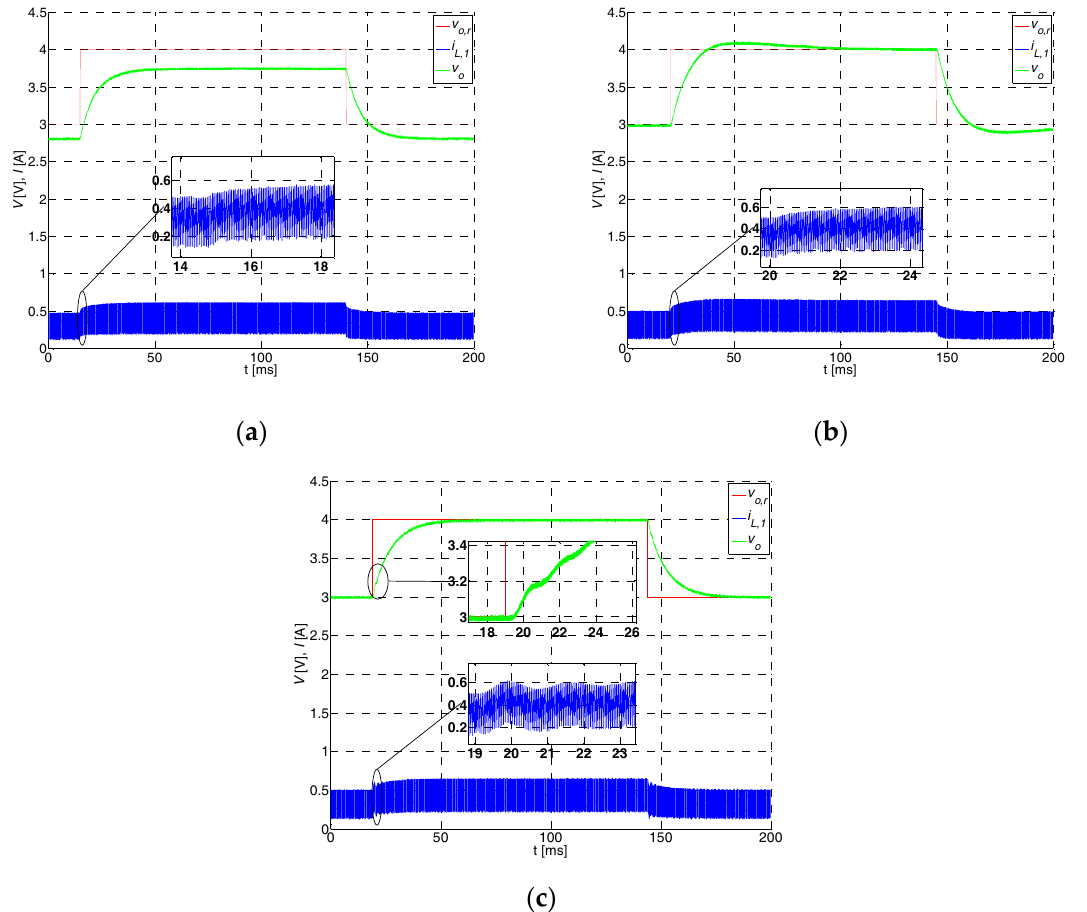
Figure 11. Output voltage response to step voltage reference change when using ( a ) P type control with 𝑖 (cid:3042) feedforward, ( b ) PI control with 𝑖 (cid:3042) feedforward, and ( c ) P control with 𝑖 (cid:3042) feedforward and disturbance observer. The load was 2 Ω